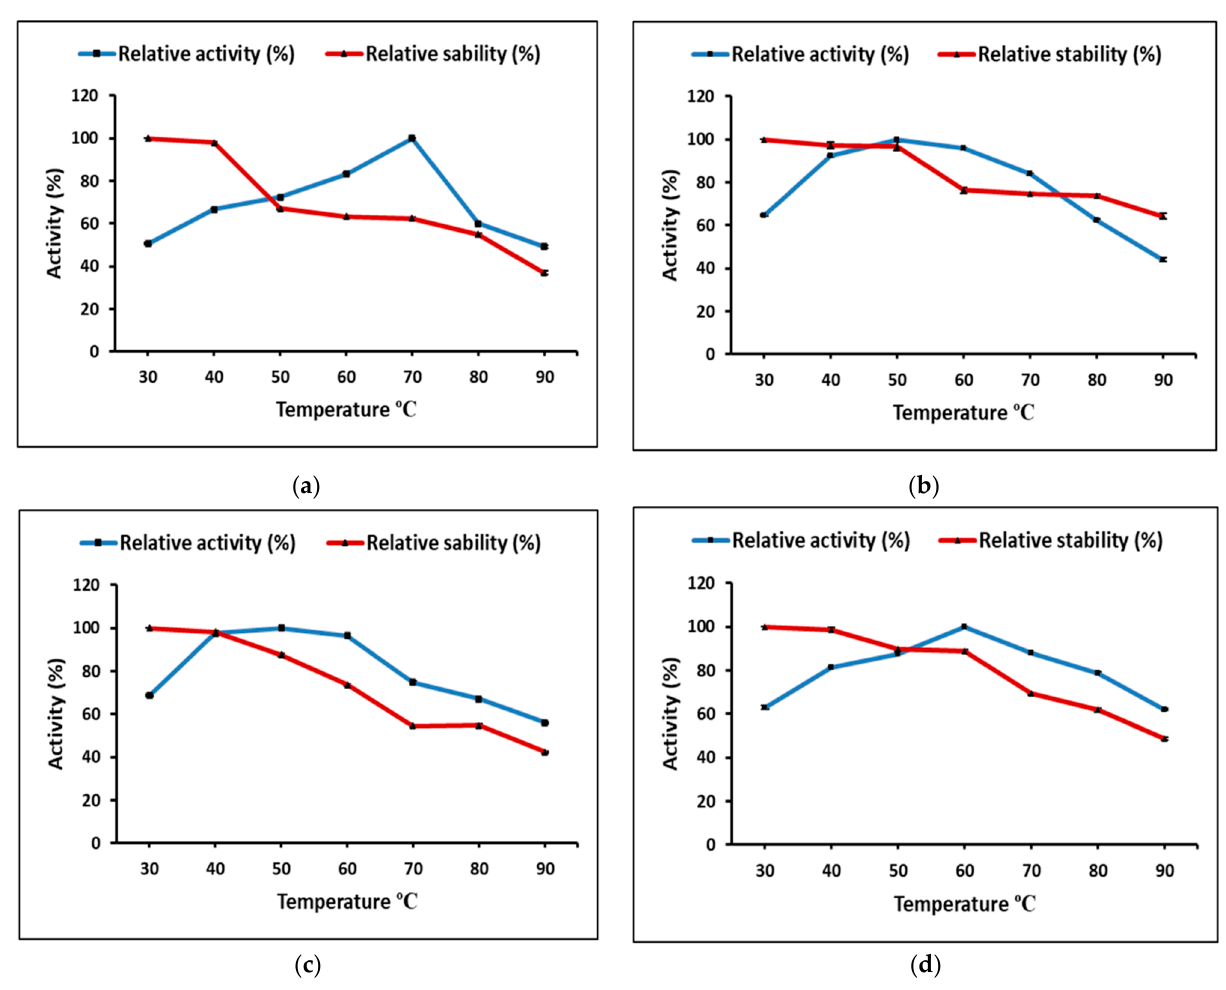
Figure 7. Effects of temperature on activity and stability of partially purified cellulase: ( a ) M. circinelloides ; ( b ) M. hiemalis ; and pectinase: ( c ) M. circinelloides ; and ( d ) M. hiemalis .